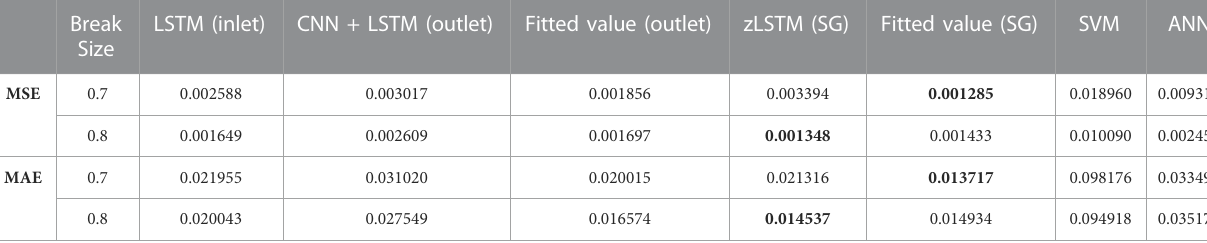
The bold values represent the best model performance in a selected